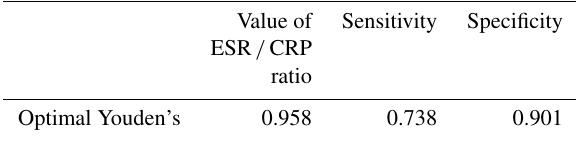
Table 2. The ideal cutoff values for the ESR / CRP